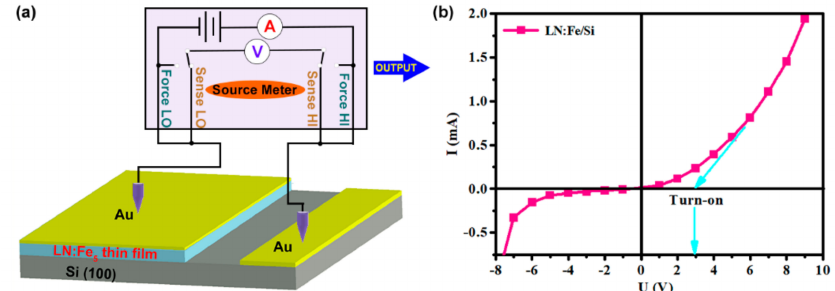
Figure 3. ( a ) Schematic diagram of the experimental setup for p-n junction LN:Fe 5 / Si. ( b ) The current-voltage curve of the LN:Fe 5 / Si junction with a turn-on voltage of 2.9 V for the forward voltage and a breakdown voltage of about − 6 V.